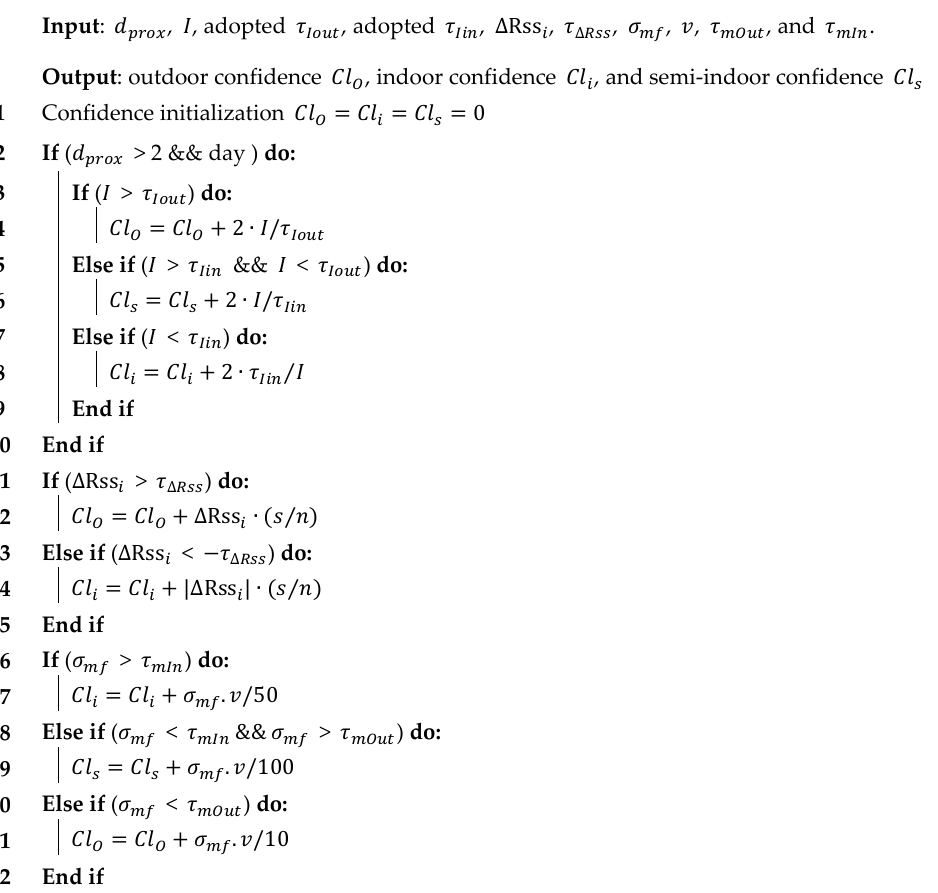
Algorithm 2: Aggregated I/O decision-based LPCS indicators